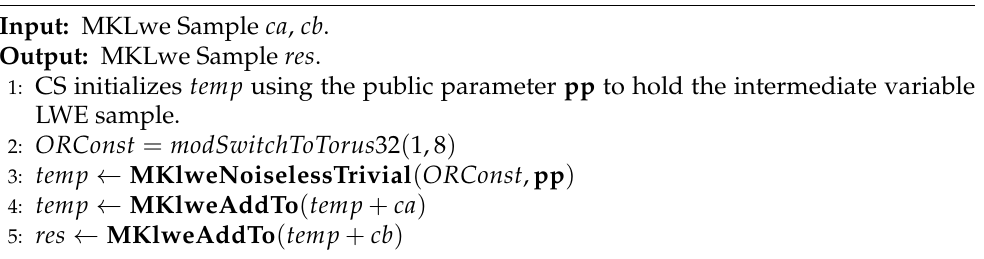
Algorithm 2 Secure OR gate computation protocol ( SC OR ).